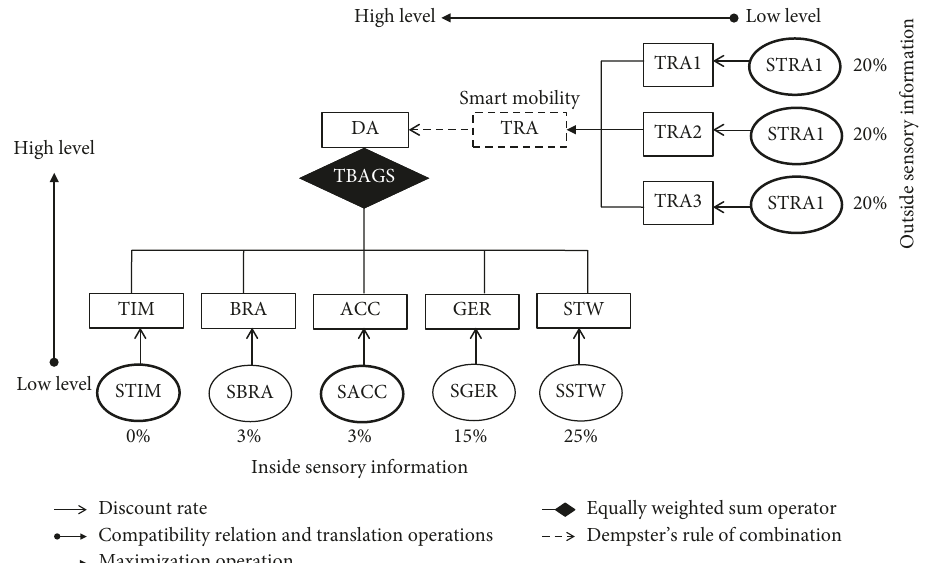
Figure 5: An example of evidential reasoning network for driving